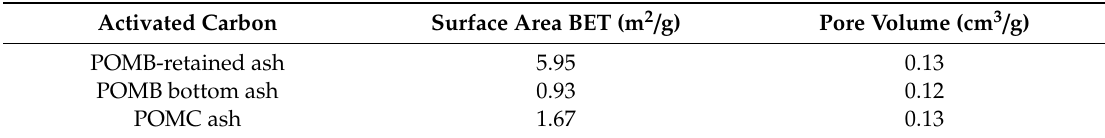
Table 3. BET analysis of POMB-retained fly ash, POMB bottom fly ash, and POMC fly ash. Activated